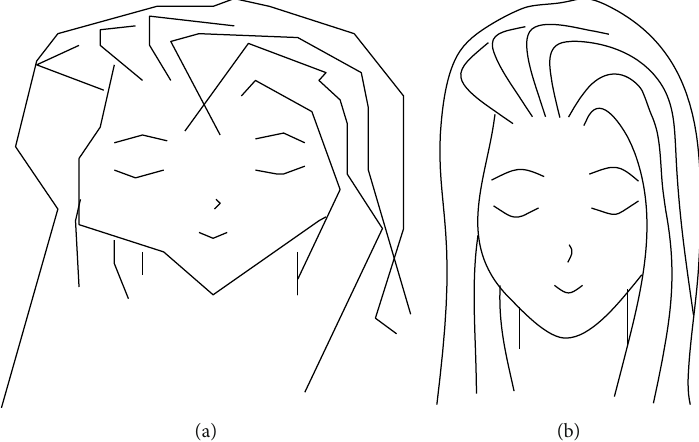
Figure 7: Application of R